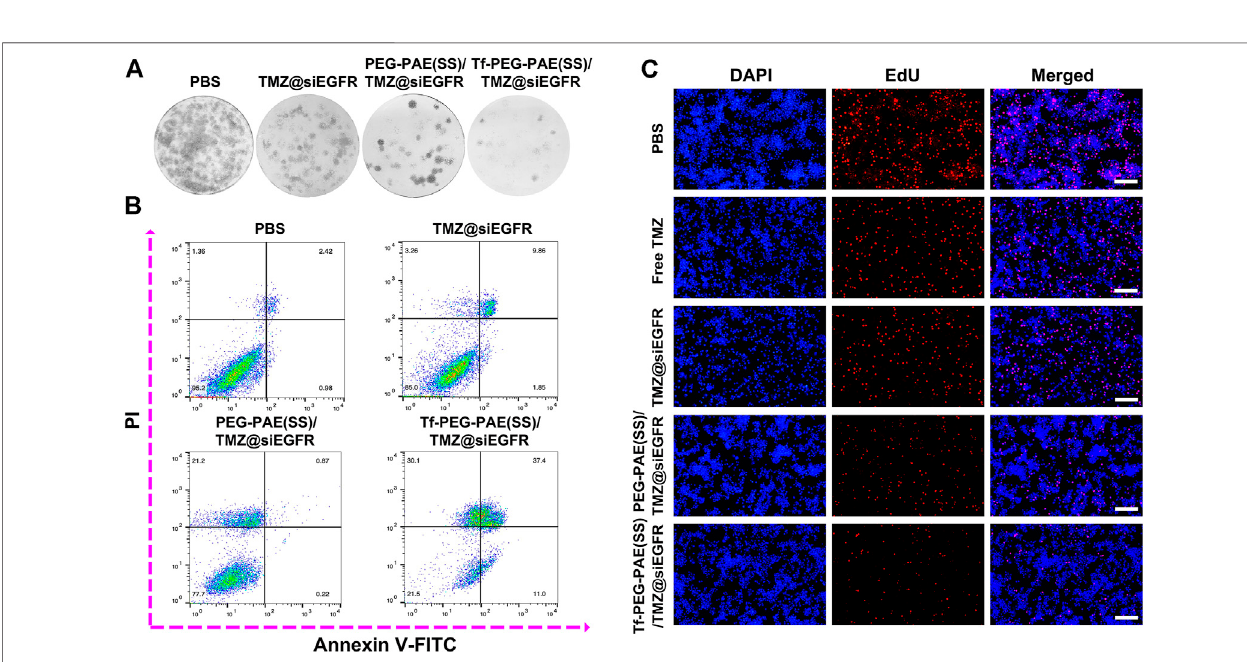
Frontiers in Genetics |